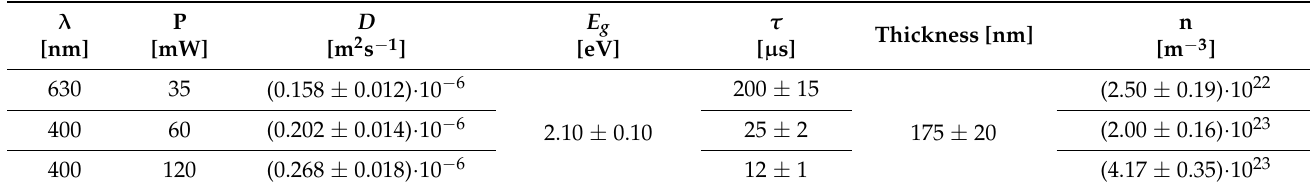
Table 1. Effective parameters of P3HT:PCBM(1:1)+PEDOT:PSS determined by BDS.